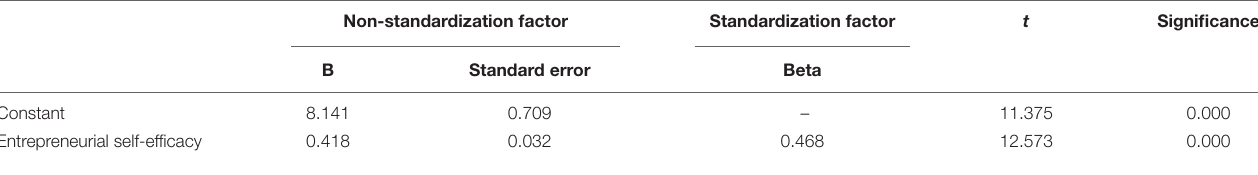
TABLE 2 | Regression analysis results of entrepreneurial self-efficacy and entrepreneurial